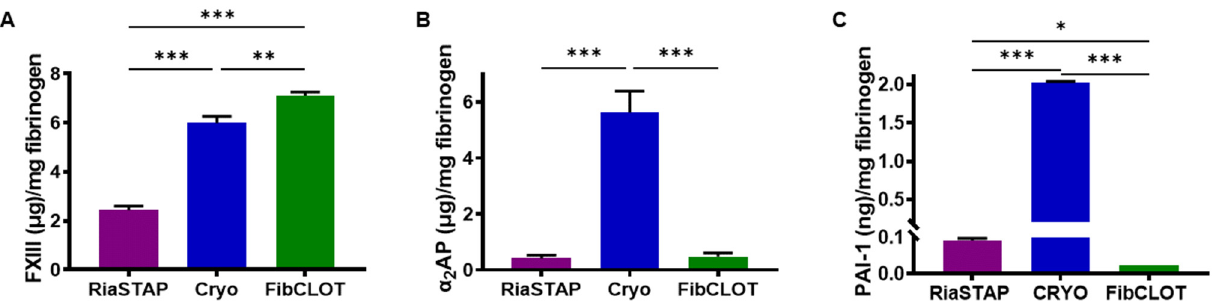
Figure 4. Quantification of FXIII, α 2 AP and PAI-1 levels in fibrinogen preparations. ( A ) FXIII, ( B ) α 2 AP and ( C ) PAI-1 in RiaSTAP ® , cryoprecipitate or FibCLOT ® was measured by a commercially available ELISA. Data are expressed as mean protein concentration ± SEM detected per mg of fibrinogen. of n = 3, * p < 0.05, ** p < 0.01, *** p < 0.001.